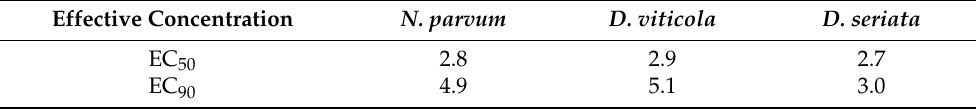
Table 5. Synergy factors for the stevioside– S. marianum conjugate complex against the three Botryosphaeriaceae